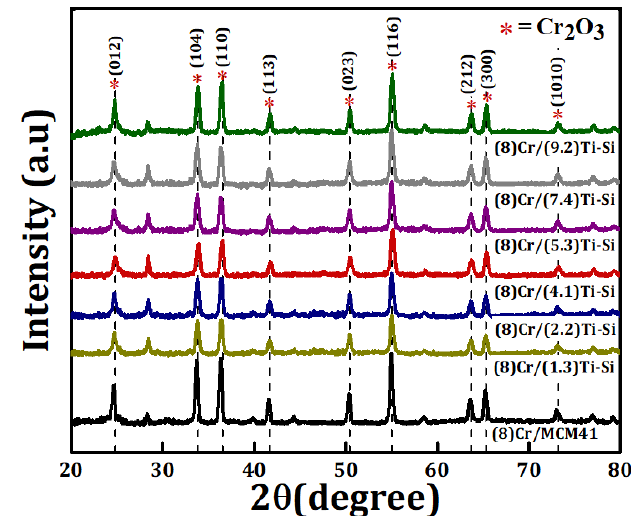
Figure 2. XRD patterns of Cr(8)/MCM ‐ 41 and Cr(8)/Ti(x)–Si prepared with varying titanium loadings, Ti wt %.